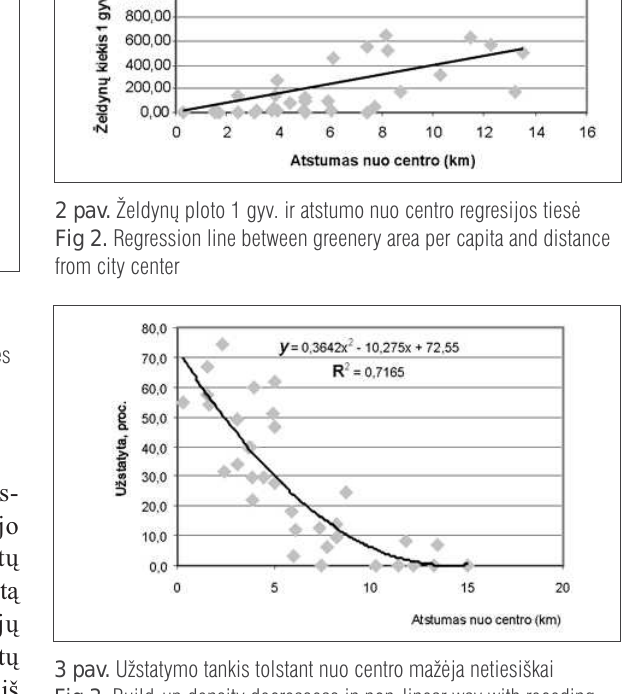
Fig 3. Build-up density decreaseas in non-linear way with receding from city center